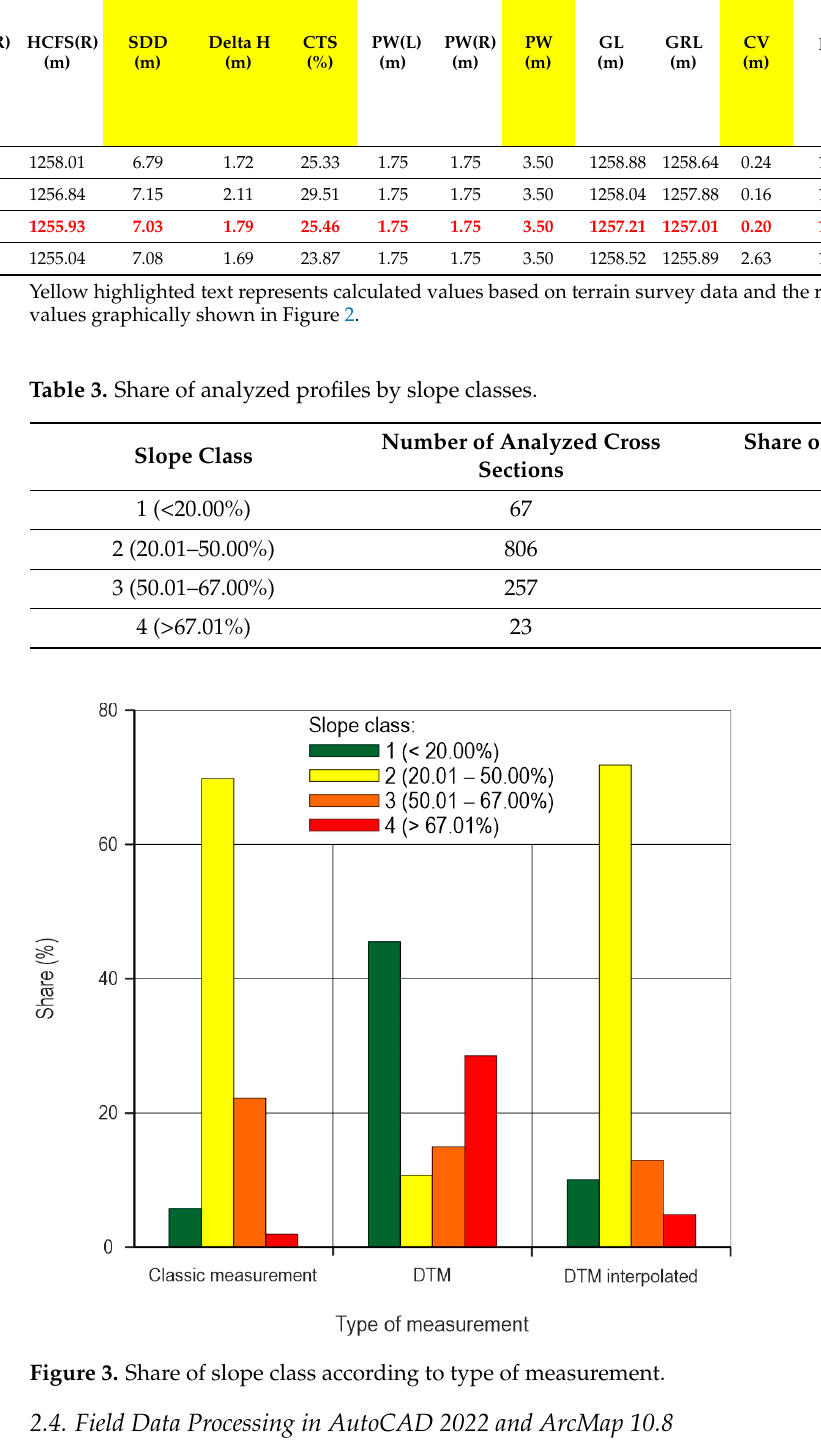
Yellow highlighted text represents calculated values based on terrain survey data and the red bold